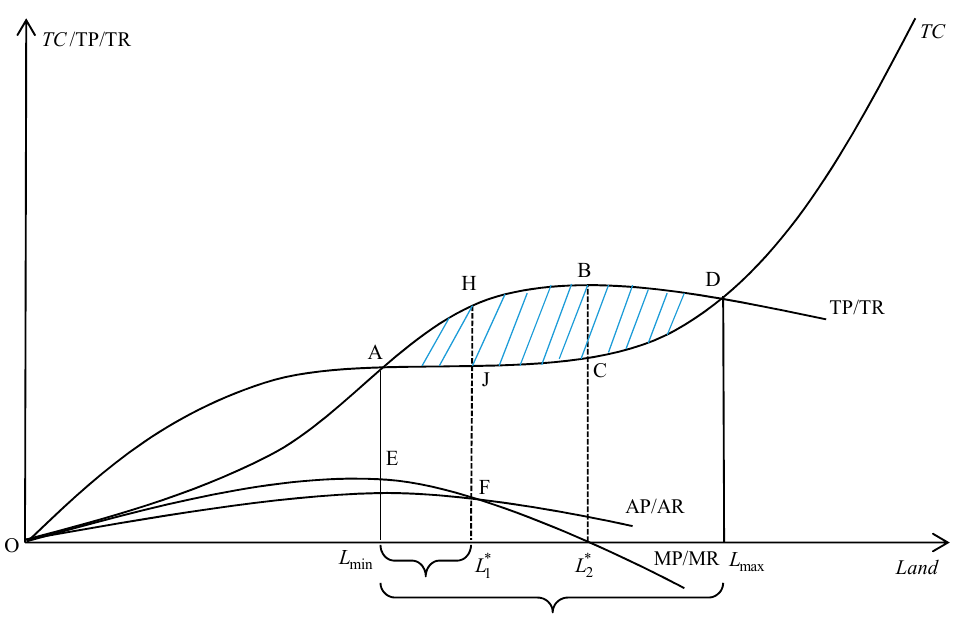
Figure 1. The moderate operation scale under output maximization, profit maximization, and unit cost minimization.